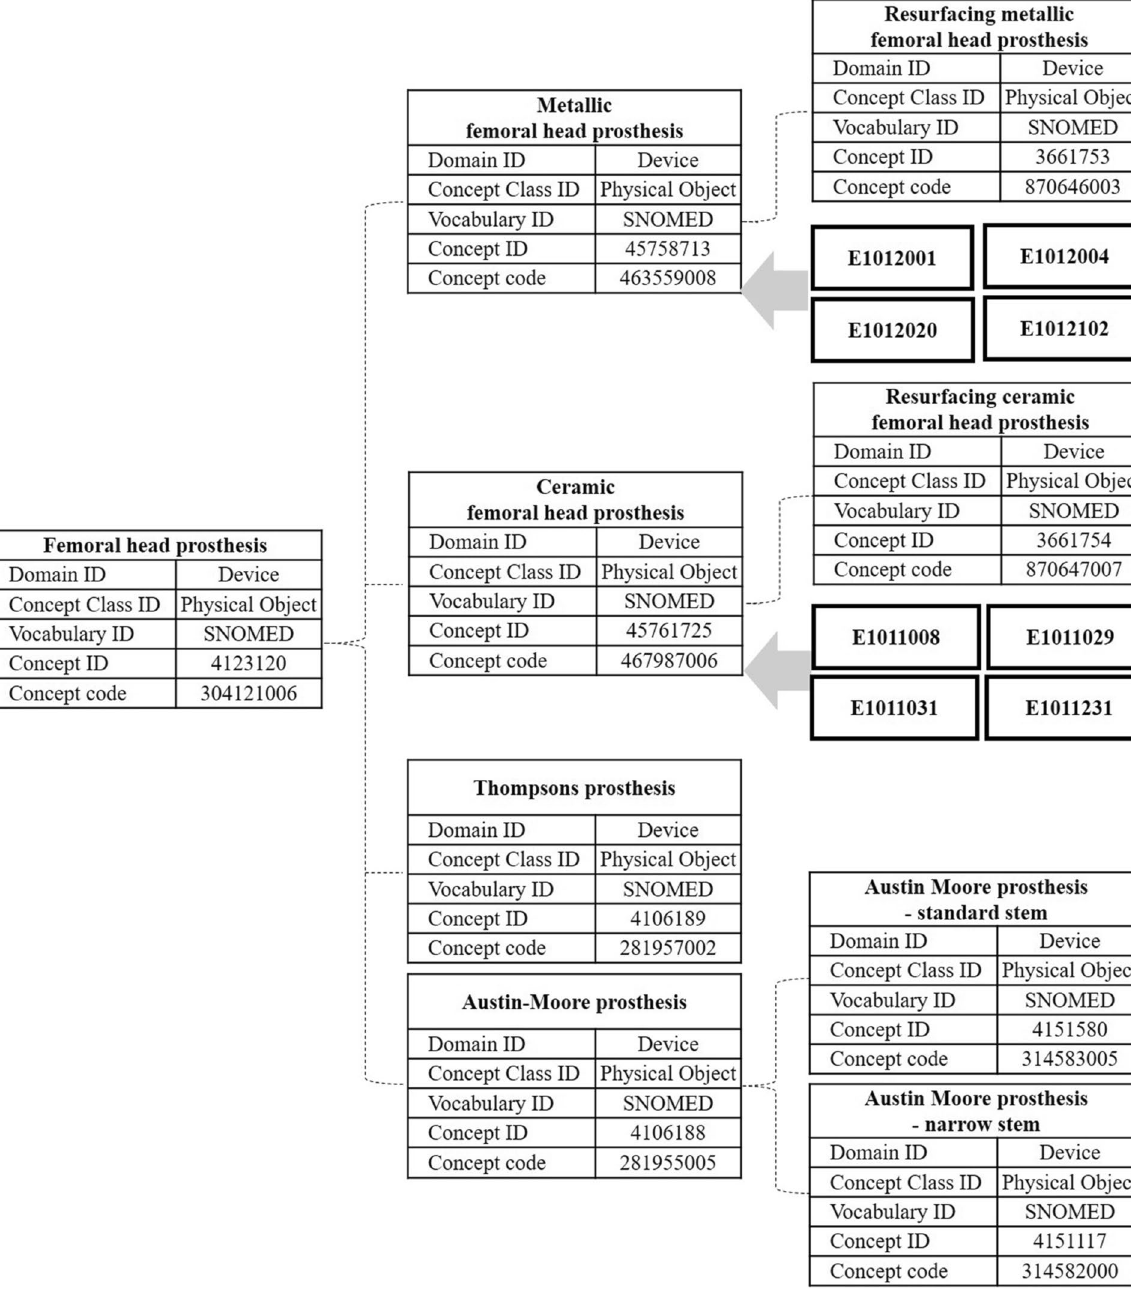
Figure 4. Femoral head hierarchy of SNOMED-CT. Only three of 11 EDI codes registered on the SCHBC CDM are mapped to the concept ID 45761725, while the remaining eight are mapped to concept ID 4558713 or 45761725 depending on the material. CDM common data model, SCHBC Soonchunhyang University Bucheon Hospital, EDI electronic data interchange, SNOMED-CT systematized nomenclature of medicine clinical